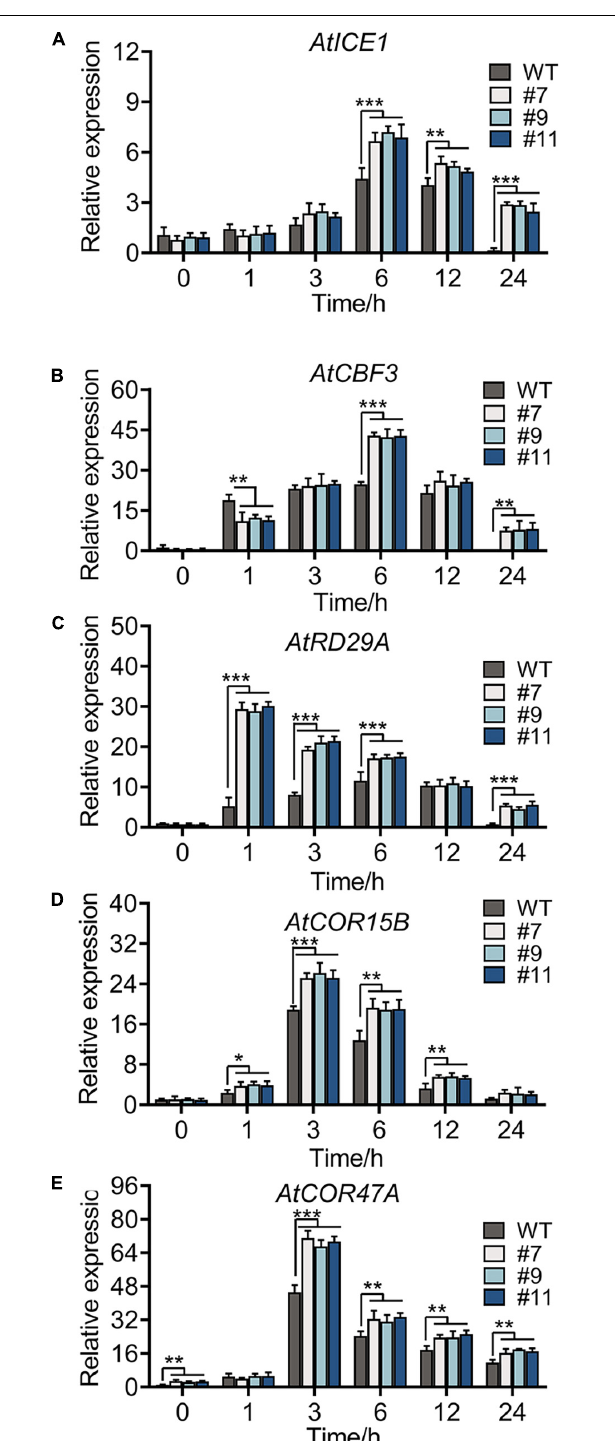
FIGURE 7 | Cold-responsive marker genes expression level of WT and OE lines under 4 ◦ C for 0, 1, 3, 6, 12, and 24 h, respectively. Relative expression level of AtICE1 (A) , AtCBF3 (B) , AtRD29A (C) , AtCOR15B (D) , and AtCOR47A (E) were measured to reveal that RmMYB108 probably improved plant tolerance by CBF-dependent under cold treatment. * p < 0.05; ** p < 0.01; *** p < 0.001 in